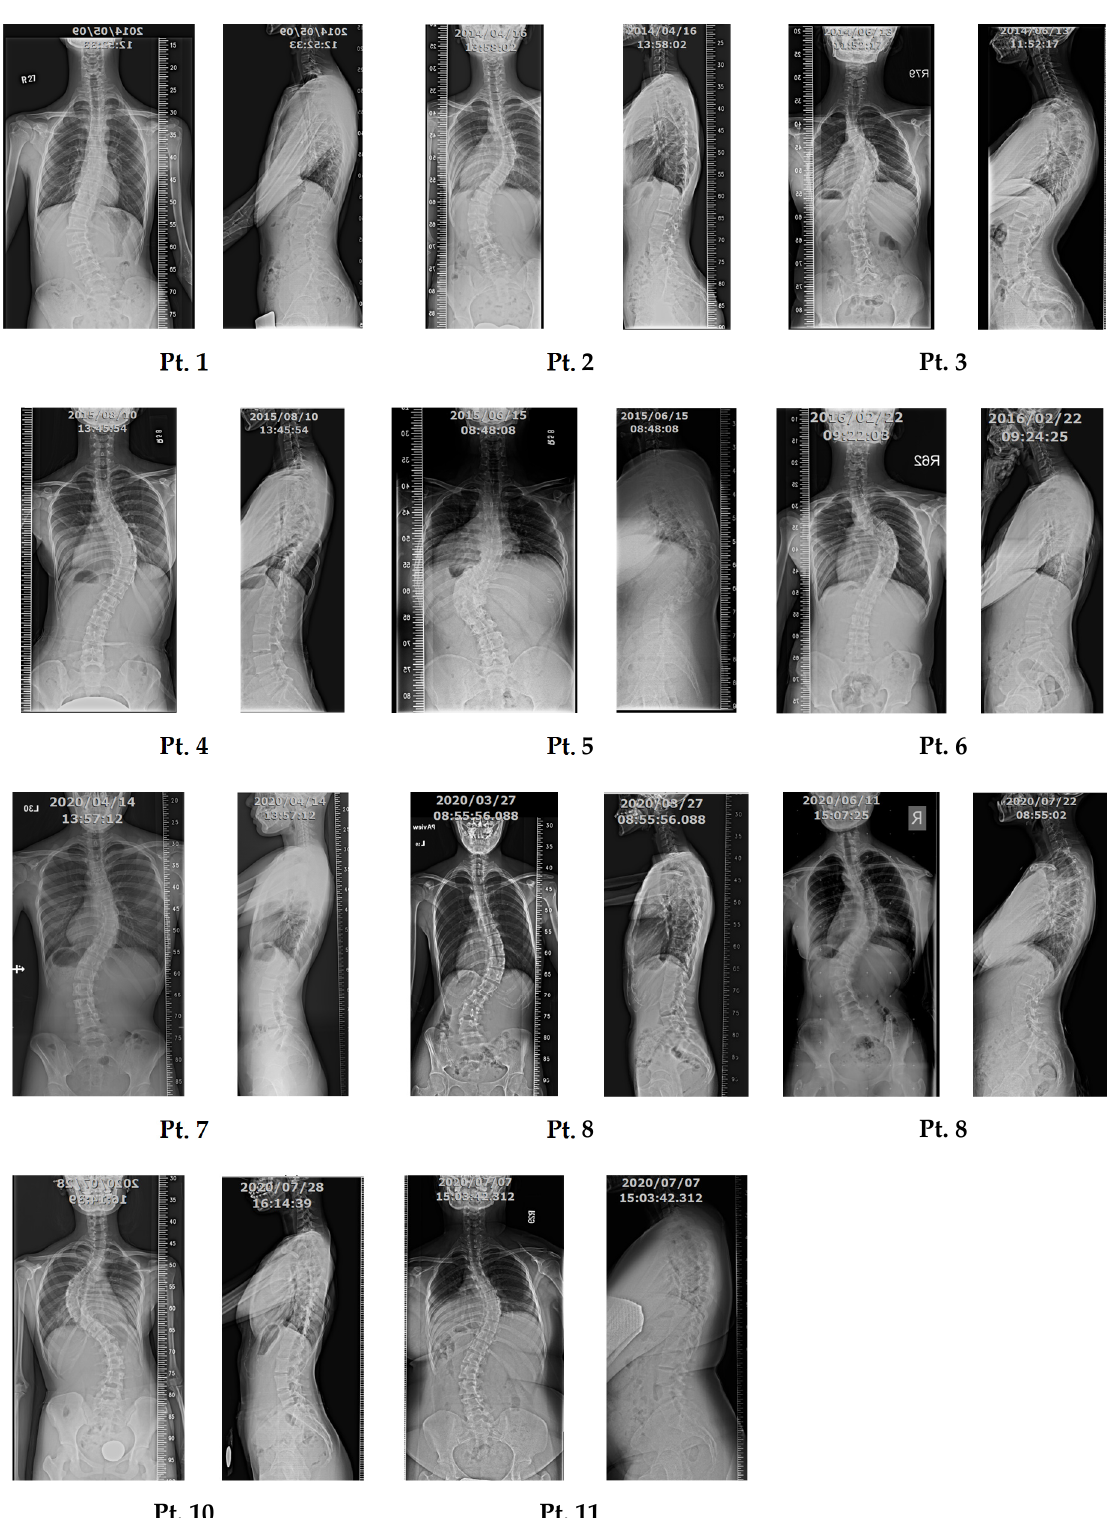
Figure 2. X-rays of 11 AIS patients. Front- and side-view X-rays of each patient were recorded before surgery. The X-ray is used to determine the severity of scoliosis.